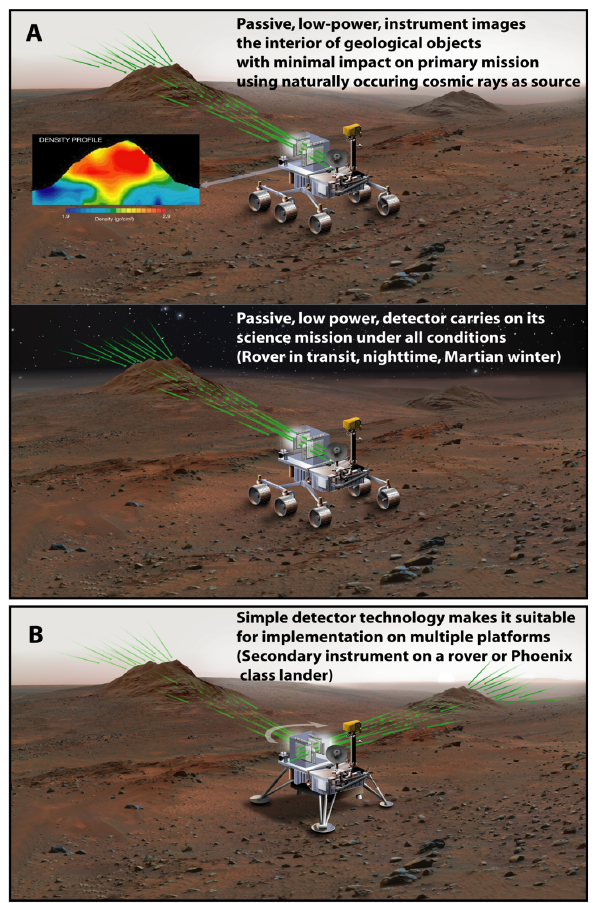
Fig. 4. Operational concept. Muons generated by interactions of pri- mary cosmic rays in the planet’s atmosphere (green spheres) pass through a geologic object of interest, and are partially absorbed by the object. A passive muon detector composed of parallel scintillat- ing plates on a lander or a rover records the tracks of the muons. The recorded tracks are analyzed on site to determine the direction from which they entered the detector and the amount of energy absorbed by the target. The observations are distilled into a density image of the geological target, much like an X-ray radiograph would, except using muons as a passive source of radiation. Two concepts are pre- sented: (A) Muon radiography instrument mounted as a secondary instrument on a rover. (B) The instrument is mounted on a small Phoenix class lander observing multiple targets during the life of the